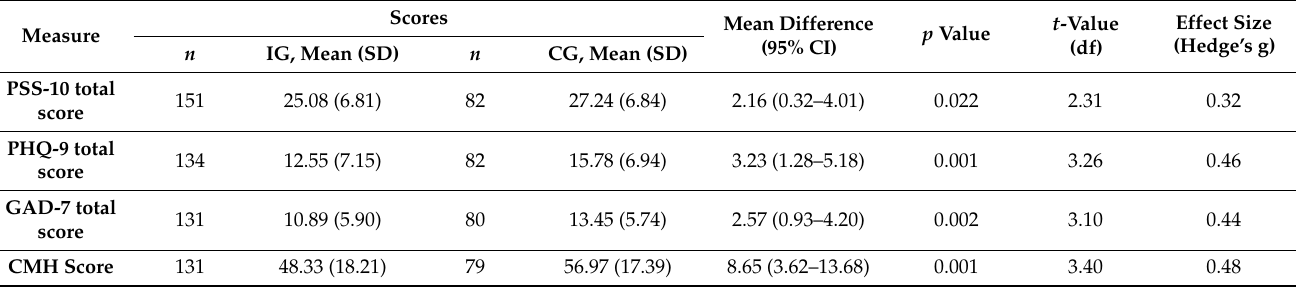
Table 8. Independent sample t -test comparing the mean scores for IG and CG on PSS, the GAD-7 and PHQ-9 scales and the Composite Mental Health (CMH)